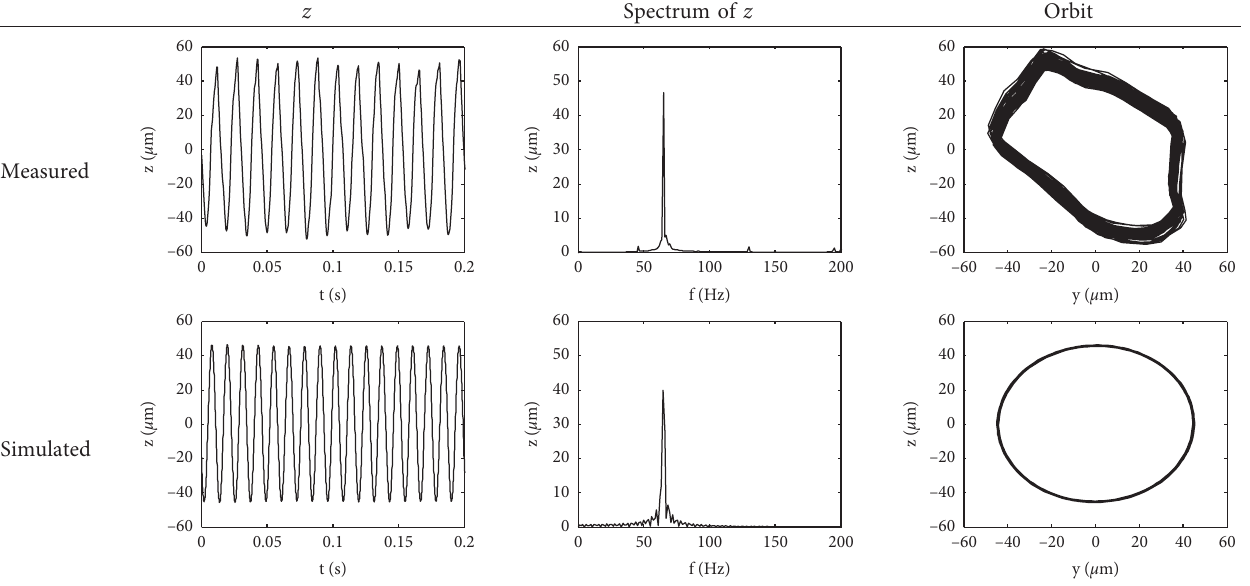
Table 7: Comparison of the vibration responses under support 2 upward 2mm condition ( h � 2mm). z Spectrum of z Orbit